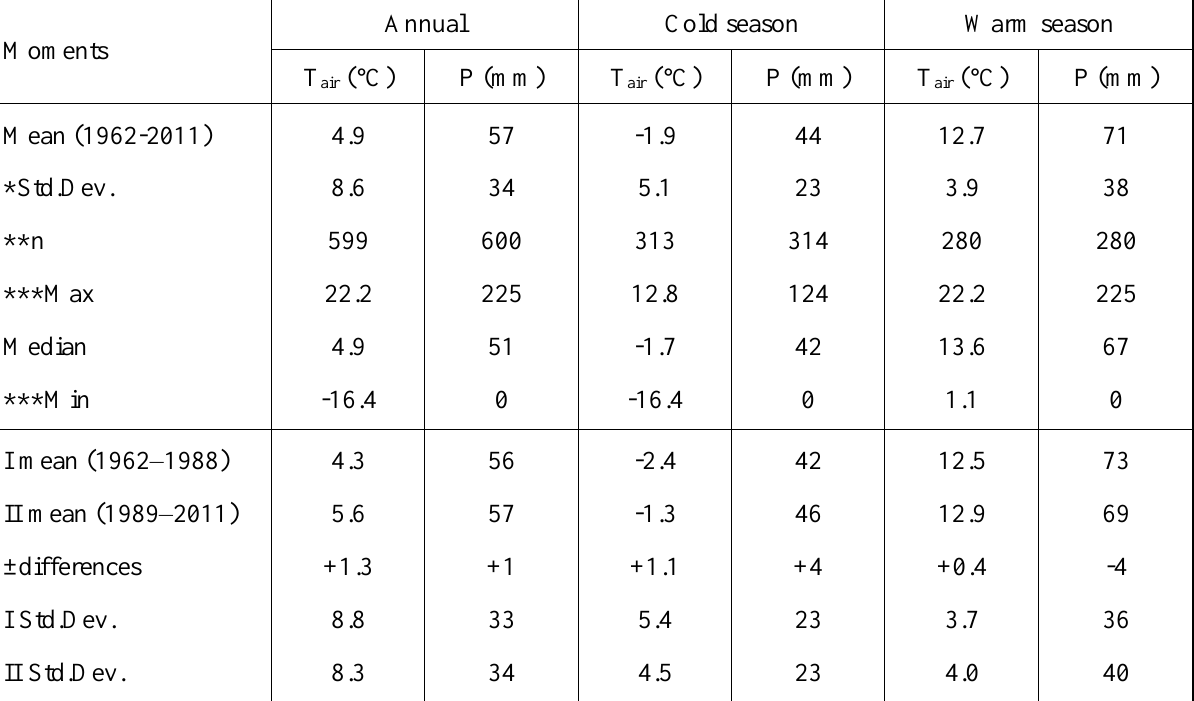
Table 1. Statistics of long-term monthly air temperature (T mineral soil meteo station together with corresponding Period I and Period II statistics. In this Table and later: *Std.Dev. = standard deviation, **n = length of the data range, ***Max, Min = maximum and minimum, respectively.